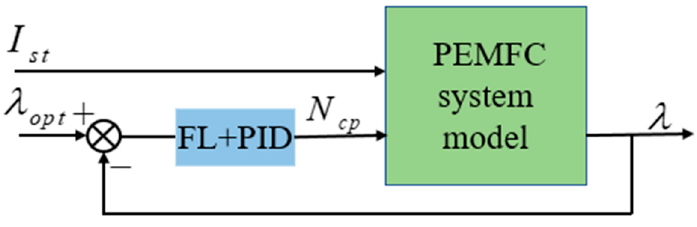
Figure 8. Structure of fuzzy logic plus PID controller.